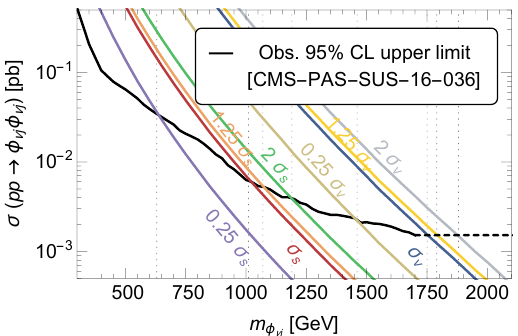
Figure 8 . Bounds on scalar and vector MLQs which decay into ( (cid:23)j )( (cid:23)j ) (cid:12)nal states. The observed 95% CL upper limit on the production cross section (black solid line) is taken from light squark searches at CMS [21]. The search stopped at 1 : 7 TeV, but we extrapolated the cross section limit by assuming that it becomes independent of LQ mass for large masses (black dashed line). The theoretical cross sections for di(cid:11)erent MLQs which can decay into ( (cid:23)j )( (cid:23)j ) (cid:12)nal states are shown as colored lines and labeled with their cross sections. The intersects (vertical dotted lines) correspond to lower limits on the MLQ